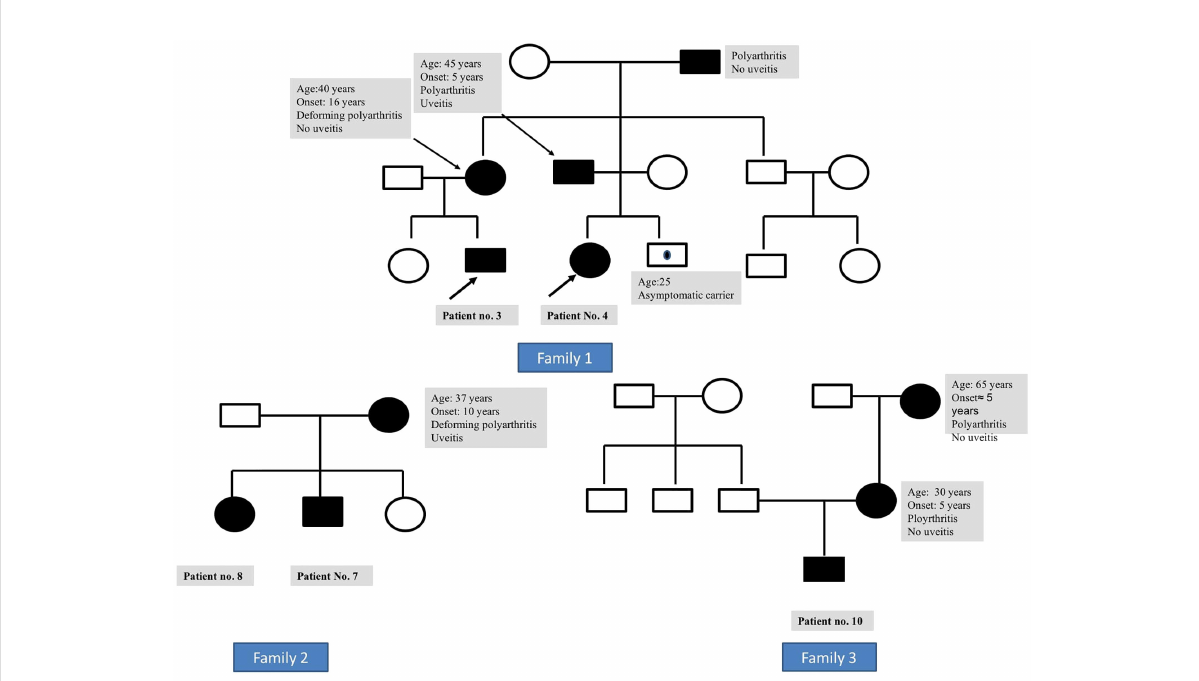
FIGURE 2 Family 1: pedigree of patient nos. 3 and 4 (siblings) showing disease manifestations in affected individuals with Blau syndrome. Family 2: pedigree of patient nos. 7 and 8 showing disease manifestations in affected individuals with Blau syndrome. Family 3: pedigree of patient no. 10 showing disease manifestations in affected individuals with Blau